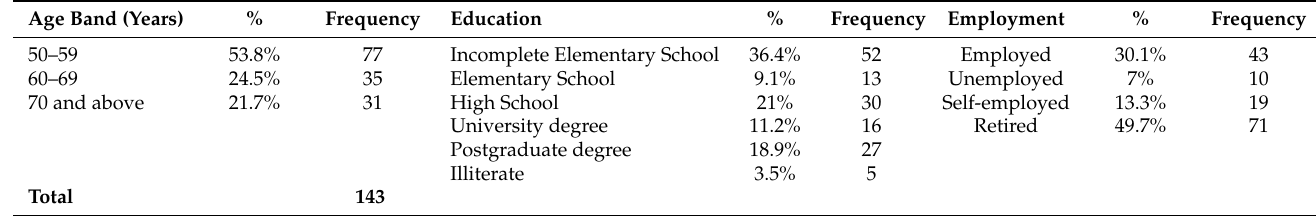
Table 1. Survey demographics.